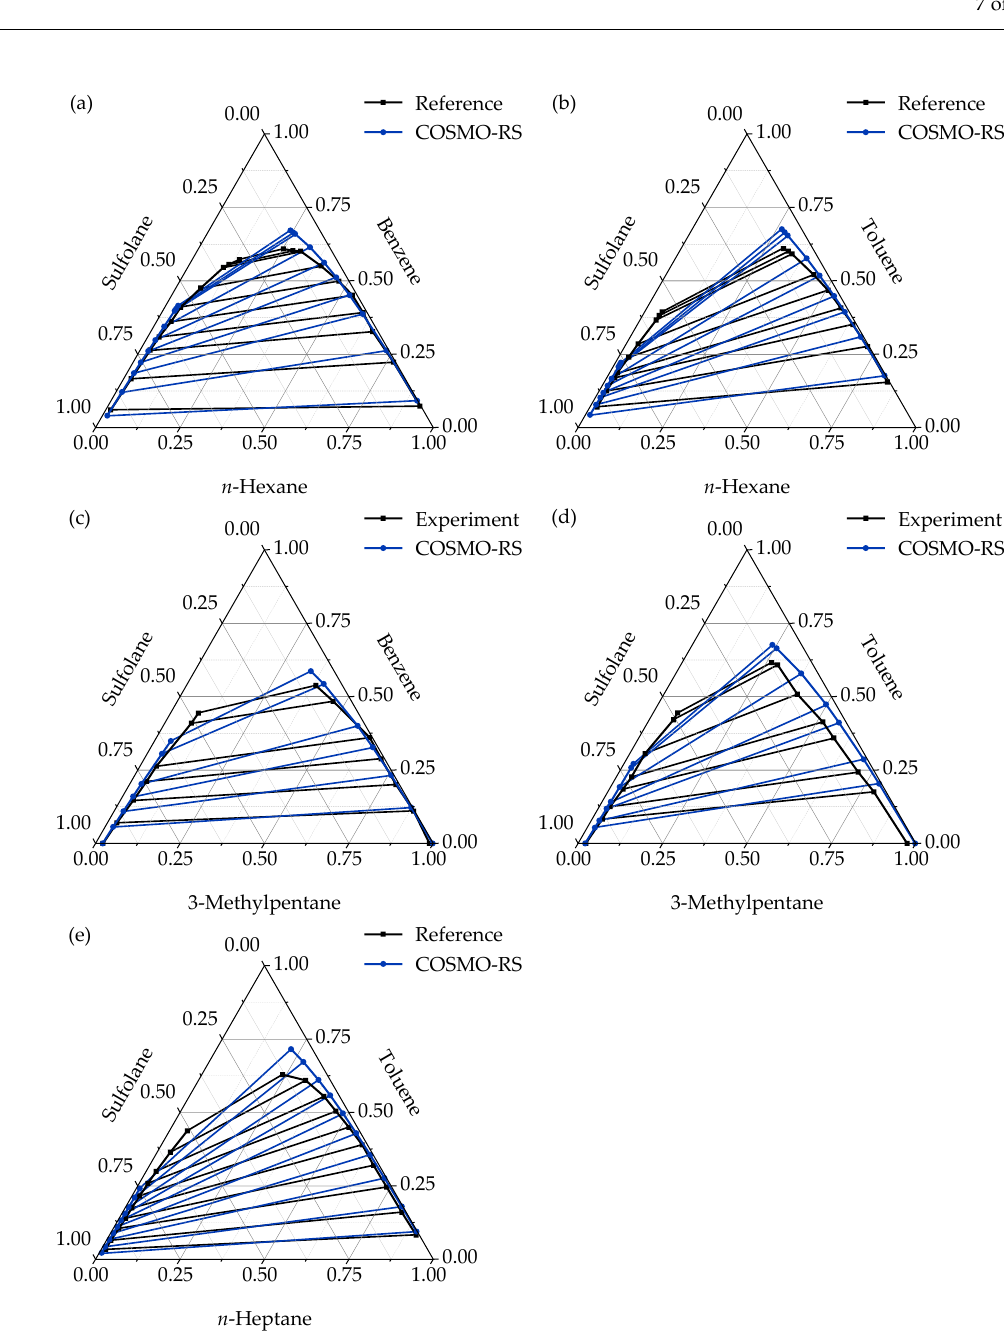
Figure 2. Ternary LLE data for ( a ) n -hexane (1)–benzene (2)–sulfolane (3), ( b ) n -hexane (1)–toluene (2)–sulfolane (3) systems at 298.15 K and 101.3 kPa, and ternary LLE data for ( c ) 3-methylpentane (1)–benzene (2)–sulfolane (3) and ( d ) 3-methylpentane (1)–toluene (2)–sulfolane (3) systems at 313.15 K and 101.3 kPa, and ternary LLE data for ( e ) n -pentane (1)–toluene (2)–sulfolane (3) system at 298.15 K and 101.3 kPa. ( ■ ) Reference [30,31] or experimental data; (●) calculated data using the COSMO-RS model. (The method of Roozeboom was used to depict the composition of the ternary phase diagram). Table 3 shows the parameters a , b , c , and d for the Hand and Othmer–Tobias equations and the correlation coefficients R 2 for the different LLE data. Figure 3 shows the correlation fitting curves for these two equations. The R 2 for both equations were close to unity, indicating the high degree of consistency with the experimental